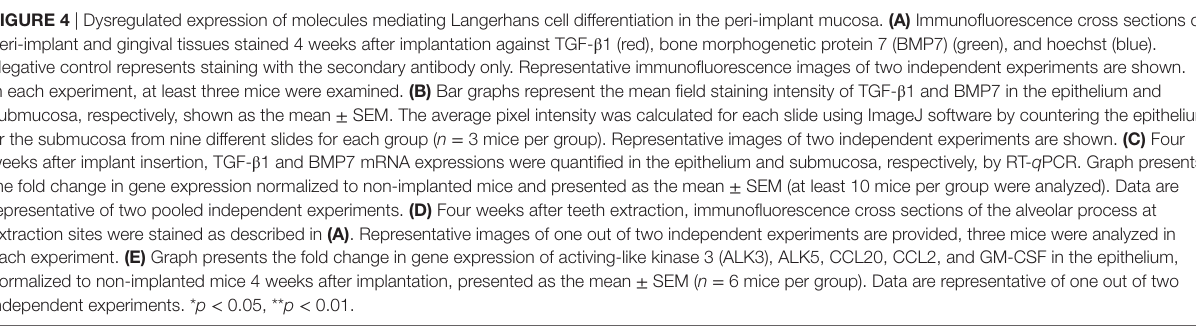
FigUre 4 | Dysregulated expression of molecules mediating Langerhans cell differentiation in the peri-implant mucosa. (a) Immunofluorescence cross sections of peri-implant and gingival tissues stained 4 weeks after implantation against TGF- β 1 (red), bone morphogenetic protein 7 (BMP7) (green), and hoechst (blue). Negative control represents staining with the secondary antibody only. Representative immunofluorescence images of two independent experiments are shown. In each experiment, at least three mice were examined. (B) Bar graphs represent the mean field staining intensity of TGF- β 1 and BMP7 in the epithelium and submucosa, respectively, shown as the mean ± SEM. The average pixel intensity was calculated for each slide using ImageJ software by countering the epithelium or the submucosa from nine different slides for each group ( n = 3 mice per group). Representative images of two independent experiments are shown. (c) Four weeks after implant insertion, TGF- β 1 and BMP7 mRNA expressions were quantified in the epithelium and submucosa, respectively, by RT- q PCR. Graph presents the fold change in gene expression normalized to non-implanted mice and presented as the mean ± SEM (at least 10 mice per group were analyzed). Data are representative of two pooled independent experiments. (D) Four weeks after teeth extraction, immunofluorescence cross sections of the alveolar process at extraction sites were stained as described in (a) . Representative images of one out of two independent experiments are provided, three mice were analyzed in each experiment. (e) Graph presents the fold change in gene expression of activing-like kinase 3 (ALK3), ALK5, CCL20, CCL2, and GM-CSF in the epithelium, normalized to non-implanted mice 4 weeks after implantation, presented as the mean ± SEM ( n = 6 mice per group). Data are representative of one out of two independent experiments. * p < 0.05, ** p <